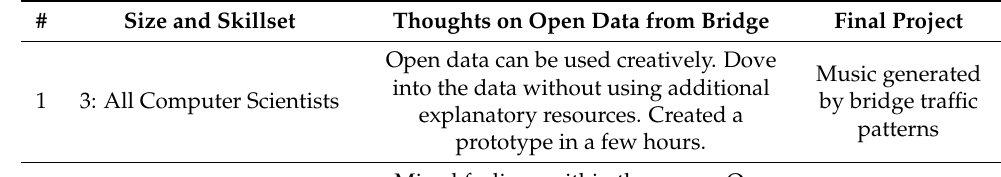
Table 3. Summary of Datathon Team